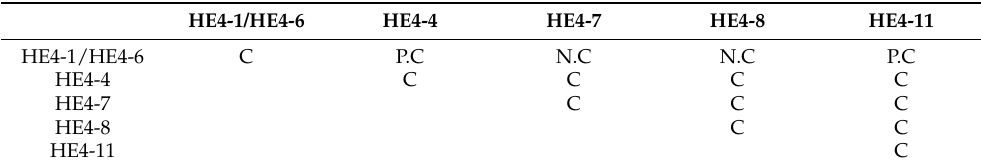
Table 2. Non-competitive Nb pair possibilities for HE4 (C—competitive; P.C—partially competitive; N.C—non-competitive).